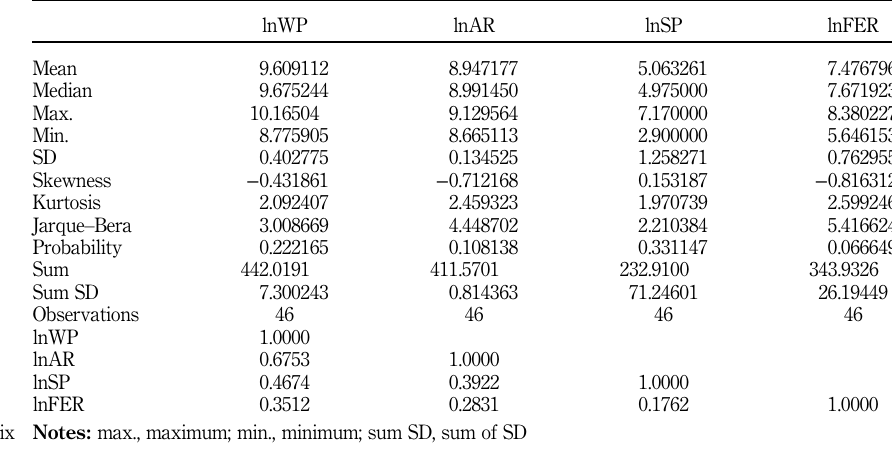
Table I. Summary of descriptive statistics and correlation